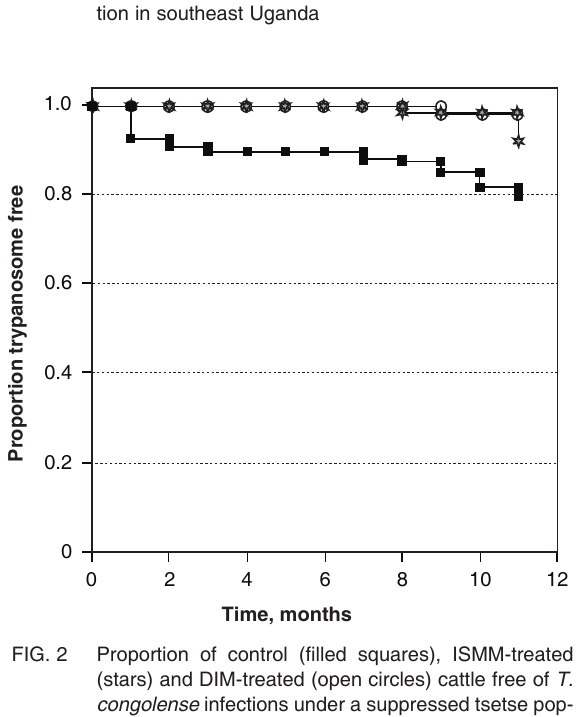
FIG. 3 Proportion of control (filled squares), ISMM-treated (stars) and DIM-treated (open circles) cattle free of T. vivax infections under a suppressed tsetse population in southeast Uganda